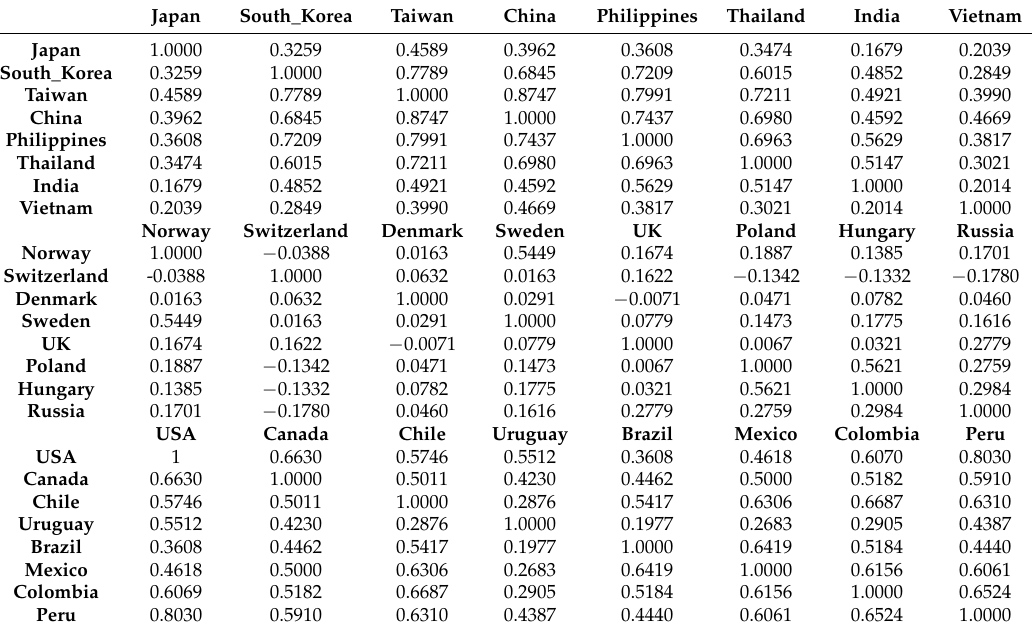
Table 11. Correlation matrix with real exchange currency data (1/3/2013 to 10/6/2014). Japan